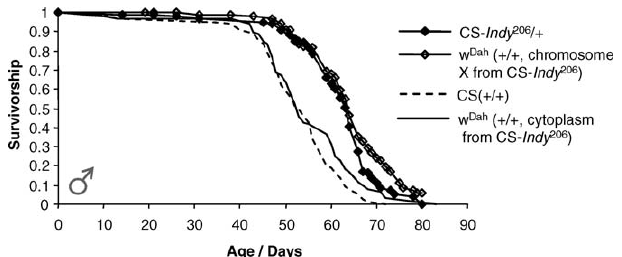
Figure 6. Modifier(s) in the Chromosome X of the CS- Indy 206 Mutant Underlies Its Longevity.